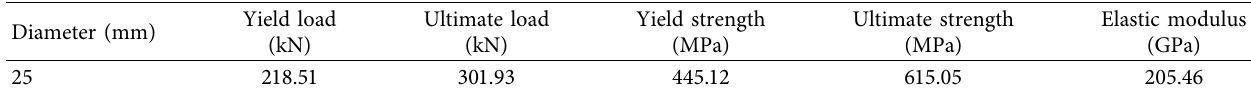
Figure 3: Schematic diagram of specimen reinforcement. (a) Specimen A and (b) specimen B1/B2. Table 2: Measured material properties of steel.